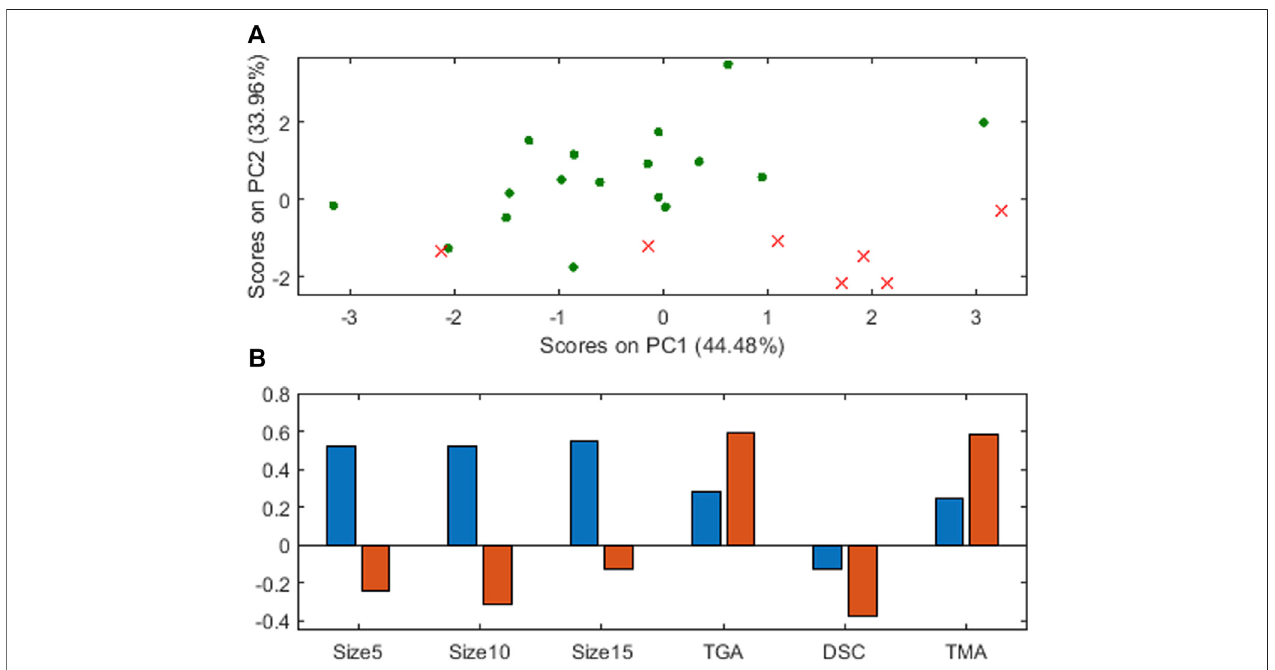
FIGURE 7 | Principal Component Analysis for plastic pellets (A) scores on the two fi rst principal components, red crosses for poor, green points for adequate objects (B) loadings, blue for the fi rst principal component, orange for the second.